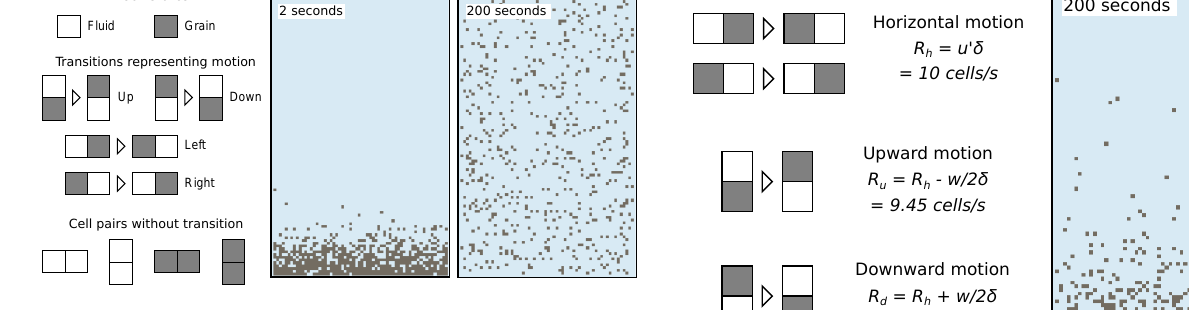
Figure 1. CellLab-CTS model of grains suspended in a stirred (tur- bulent) fluid. Left: illustration of cell states, cell-pair states, and cell-pair transitions. Grains are assumed to be neutrally buoyant, and turbulence is isotropic, so that there is an equal probability of grain motion in each direction. Grain motion is modeled as a transi- tion that switches the position of grain and fluid at a user-specified rate. In this example, we assume that the grains are 1mm diame- ter tea leaves and the characteristic turbulent velocity fluctuation is 0.01ms − 1 , so that cell size δ = 0 . 001m and the mean transition rate is 10cellss − 1 .